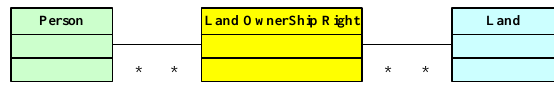
Figure 5. Core of the cadastral domain model